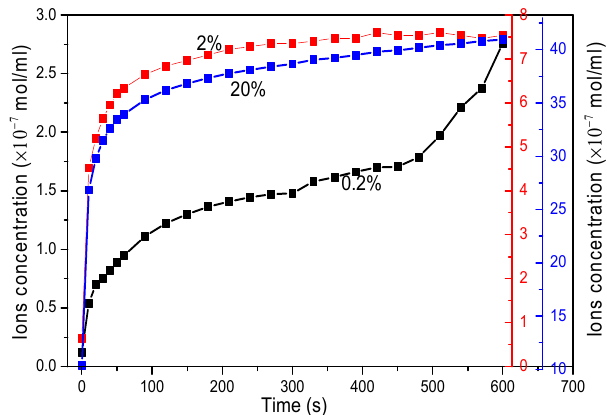
Figure 7. Ions concentration of clay aqueous solutions with different concentrations.